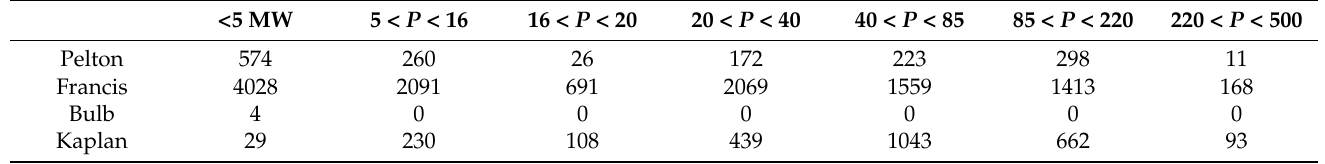
Table 4. Cumulative oil consumption (tons/year) for each power range and turbine